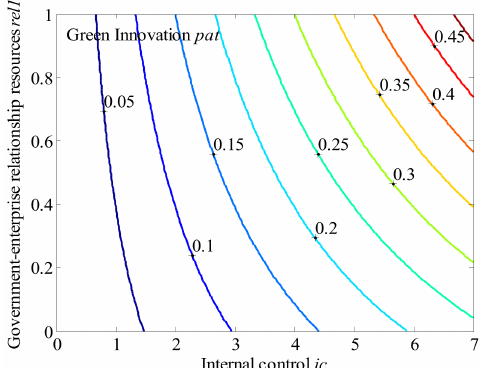
Figure 4. Regulatory effect of government–enterprise relationship